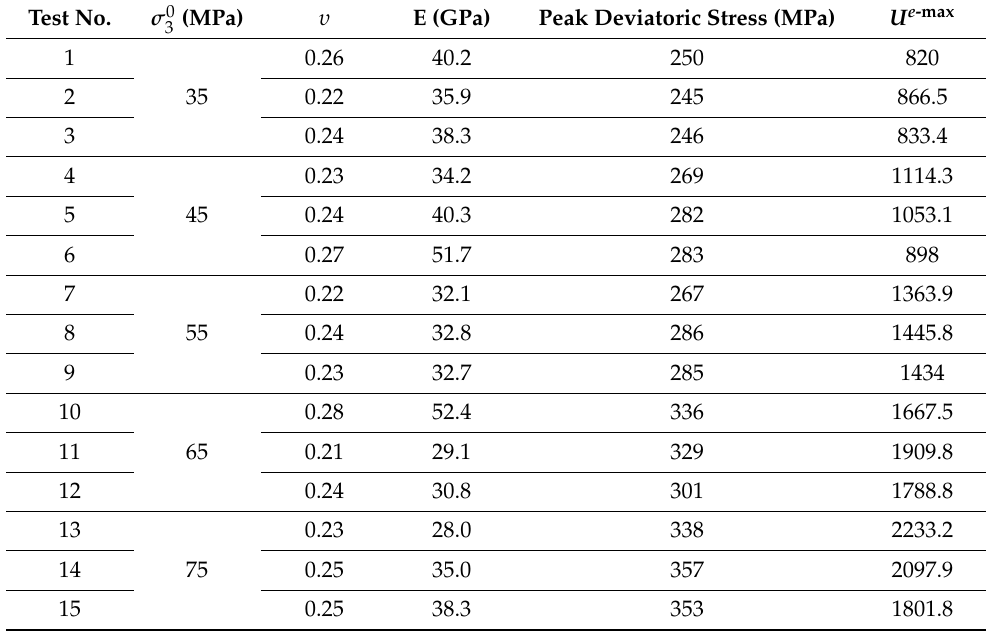
Table 5. Unloading confining stress results for sandstone in the Neelum–Jhelum Hydroelectric Project. Test